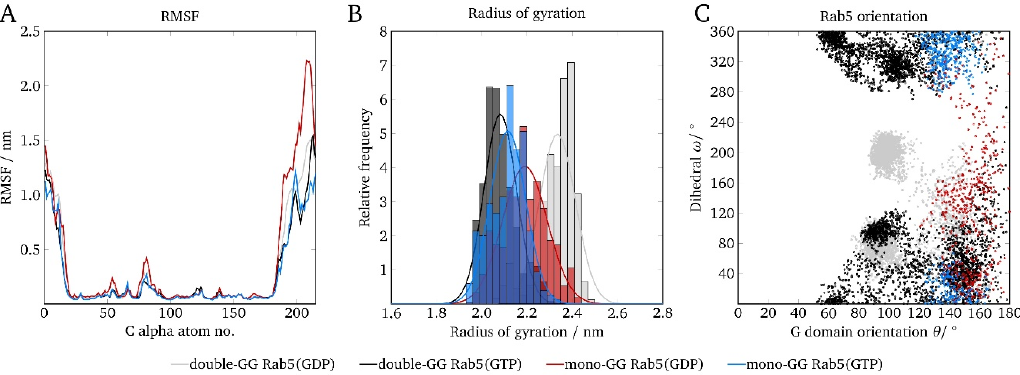
Figure 6. Comparison of mono-GG and double-GG Rab5 structural parameters in the six-component membrane with regard to ( A ) the RMSF, ( B ) the protein radius of gyration, and ( C ) the internal dihedral angle ω as a function of the G domain orientation θ.